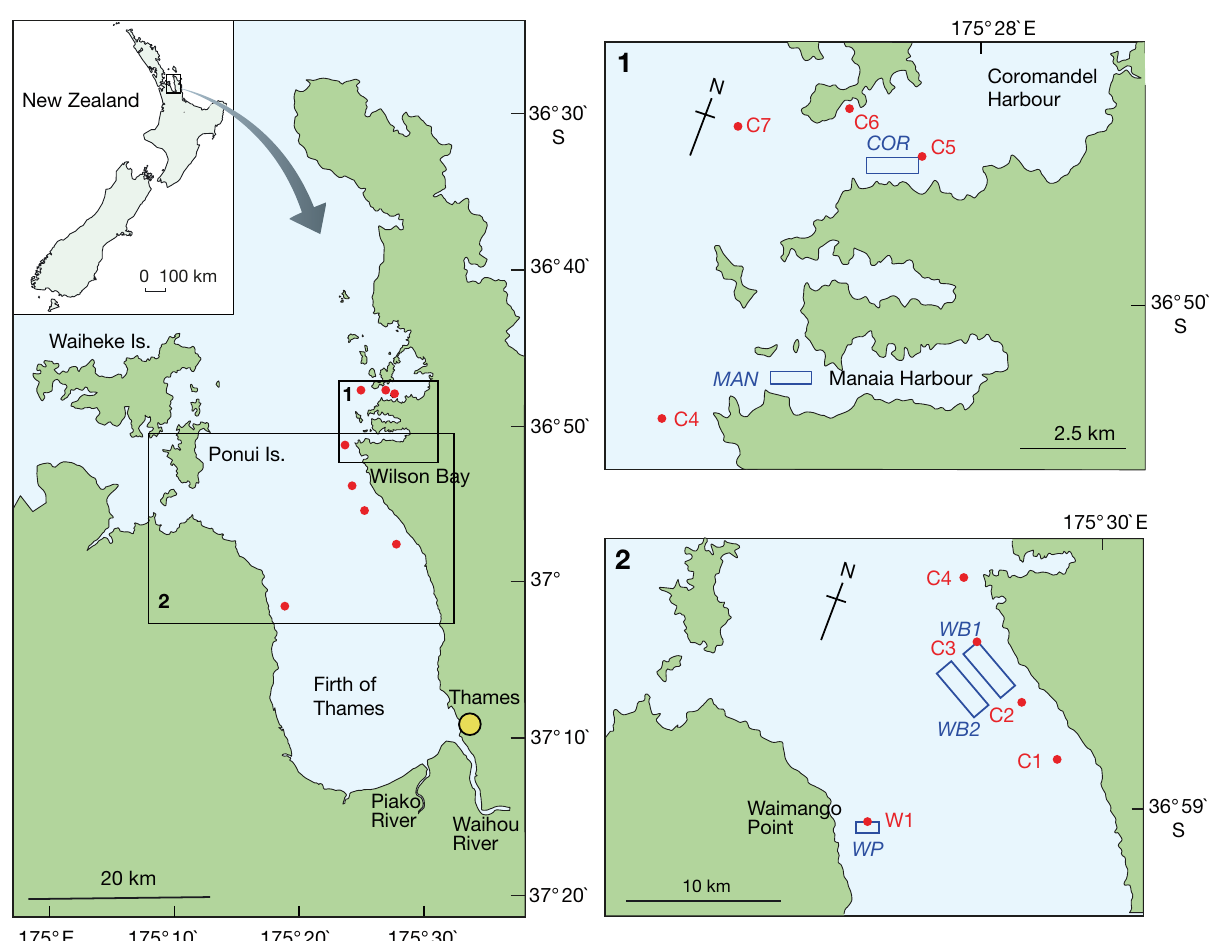
Fig. 1. The Firth of Thames in northern New Zealand, indicating sites used in this study. Blue rectangles: locations from which particles were released for biophysical modelling; red points: locations at which trace elemental fingerprinting sampling